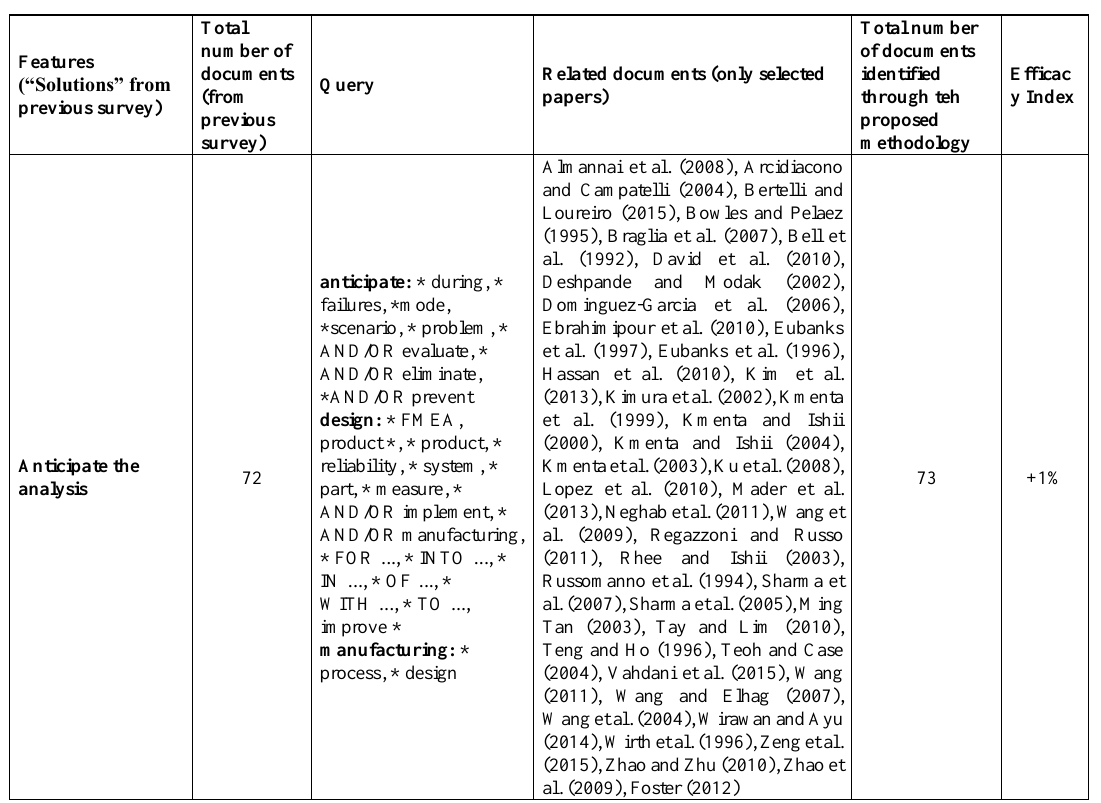
Table 6 collects the achieved results: the features, with the number of related components from previous survey, the used keywords, the selected linguistic relations, the pertinent documents (references and total number) for each feature and the index of efficacy (expressed in percentage). Table 6. Investigated solutions, used queries and identified